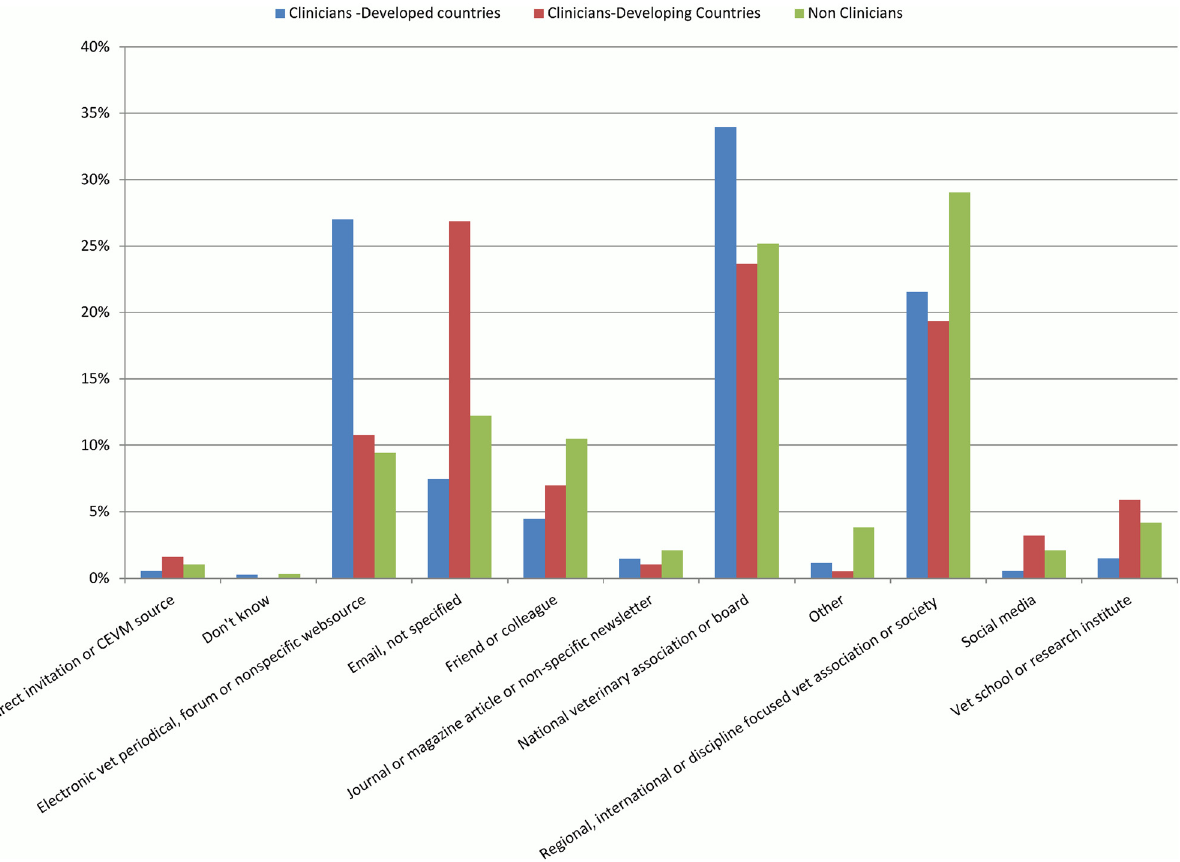
Fig 1. Source of where clinicians working in developed (n = 186) and developing countries (n = 1576), and non-clinicians (n = 286), had heard about the international questionnaire.